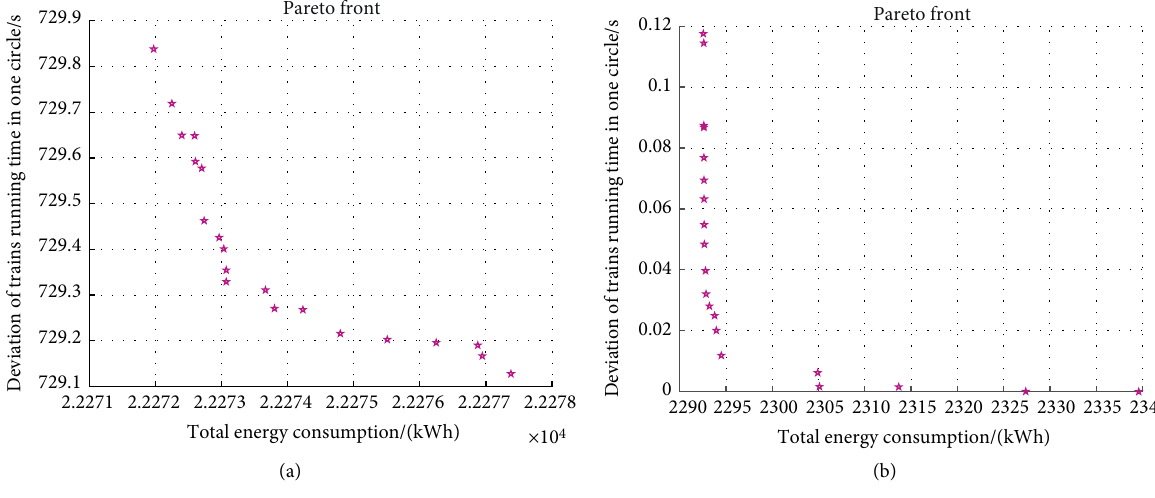
Figure 21: The Pareto front under and OIC = 0.2. (a) The Pareto solutions of the OEST. (b) The Pareto solutions of the OQOST. 𝐺 = 250